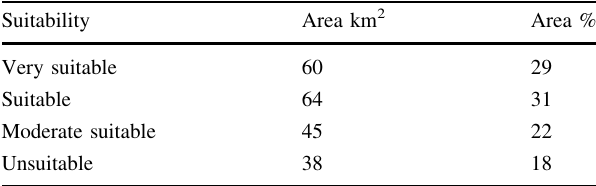
Table 2 Recharge